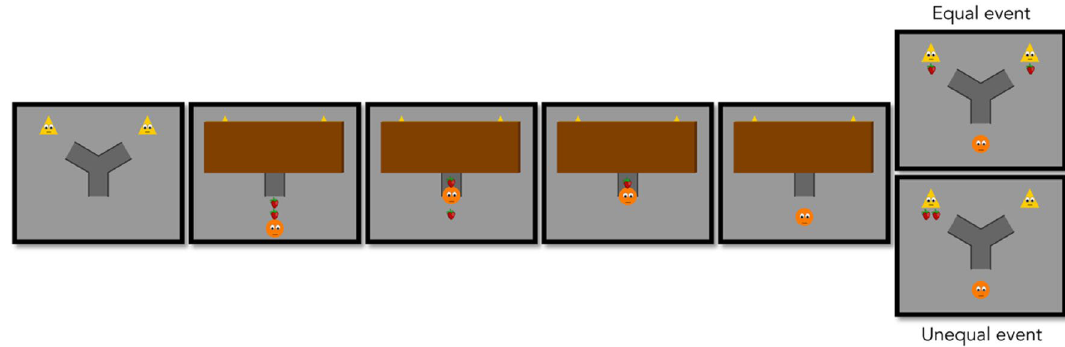
Figure 1. Selected frames from the test phase of the fairness